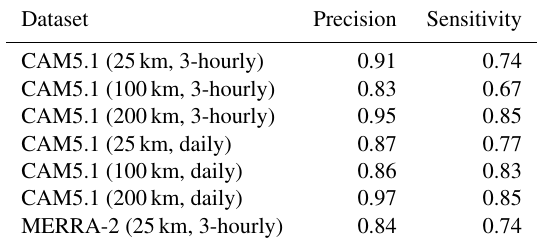
Table 6. Confusion matrix of the method for testing set – the CAM5.1 data (3-hourly, 25km), which show the number of cor- rectly classified (diagonal) and incorrectly classified events (off- diagonal).